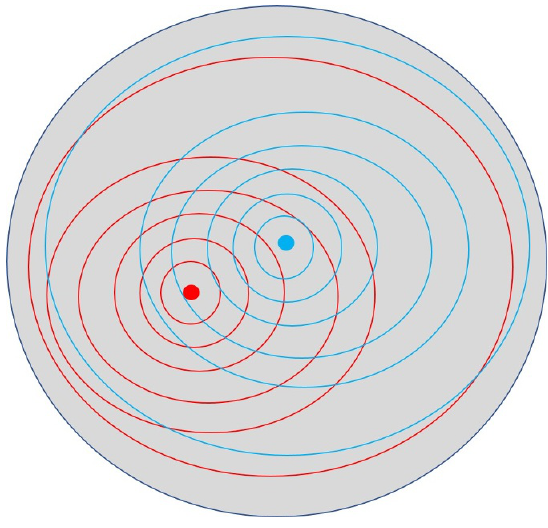
Figure 19 . Exotic quantum Cauchy slices of the HaPPY code holographic